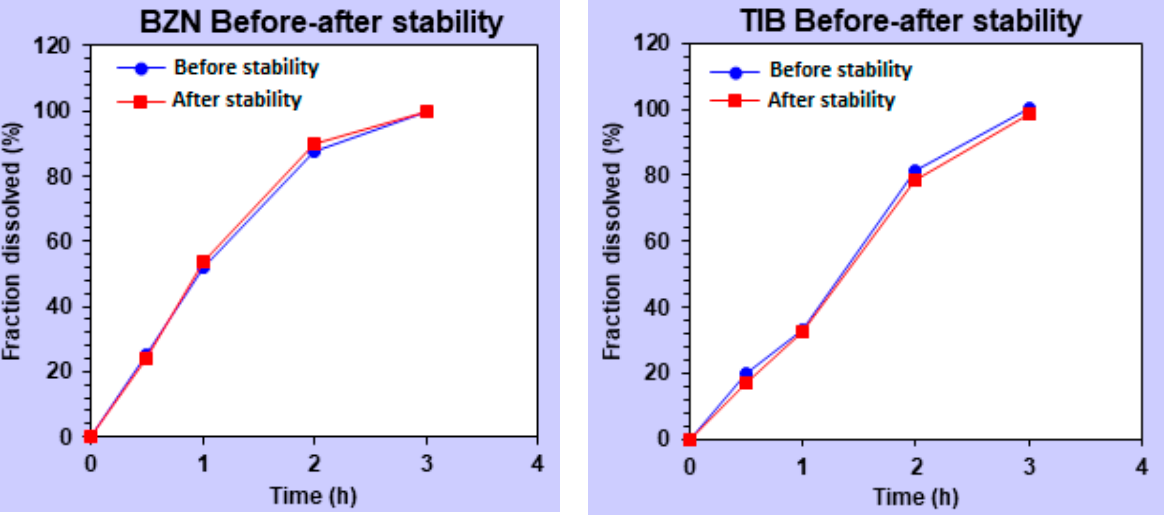
Figure 7. The similarity profile ( f 2 ) of benzocaine and tibezonium iodide after the stability study. Table 4. Similarity and similarity index of the optimized formulation undergoing a stability study. Parameter